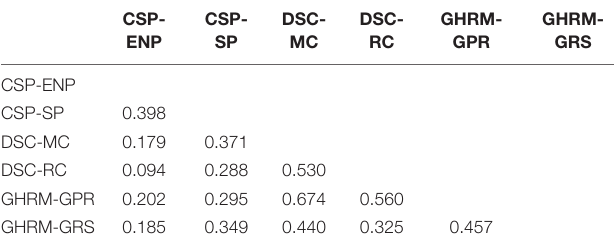
TABLE 4 | HTMT ratio–Discriminant validity.